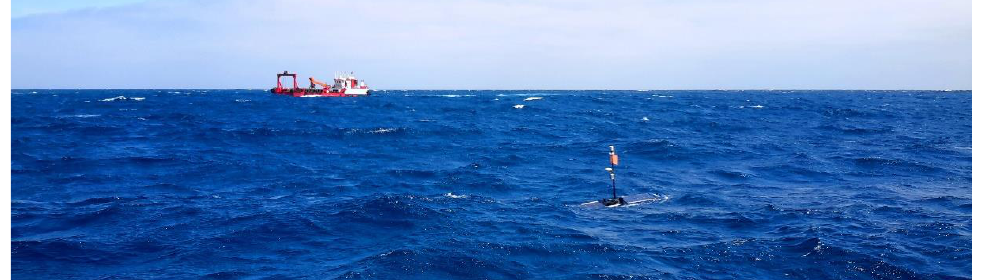
Figure 5. Wave Glider SV2 in operation nearby a ship.